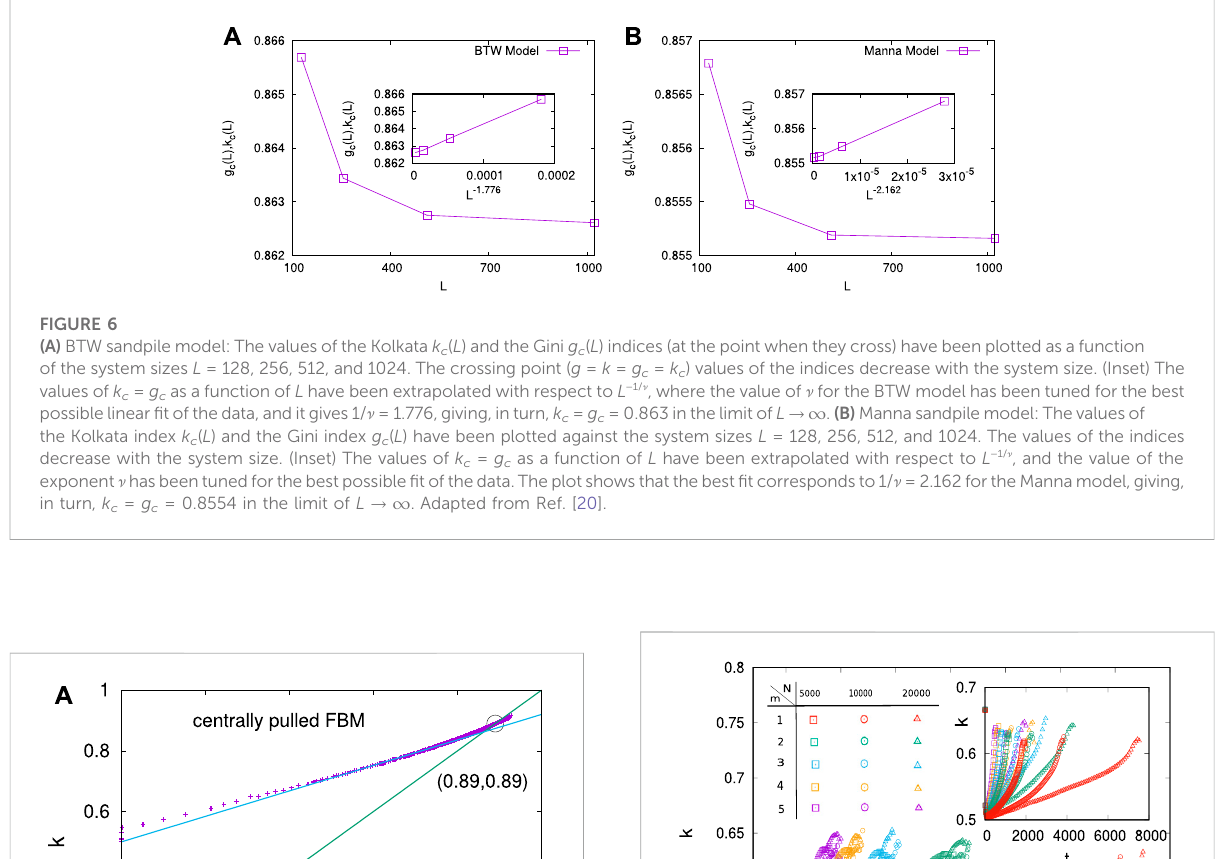
FIGURE 8 Kolkata index k for the avalanche distribution D ( Δ ) as the dynamics of failure continues in the FBM (in the ELS scheme), where the individual fi ber thresholds are drawn from a Weibull distribution. The estimated values of the index k at different times t (scaled by N /log N ) are plotted until complete failure of the bundle (with disorder characterized by different Weibull moduli ( m ) indicated using different colors). The terminal value of the k - index,prior tocompletefailurebundle,seemstoreachathreshold (0.62 ± 0.03), and this terminal value is weakly dependent on m . The inset shows the variations of the k index with unscaled time. Taken from